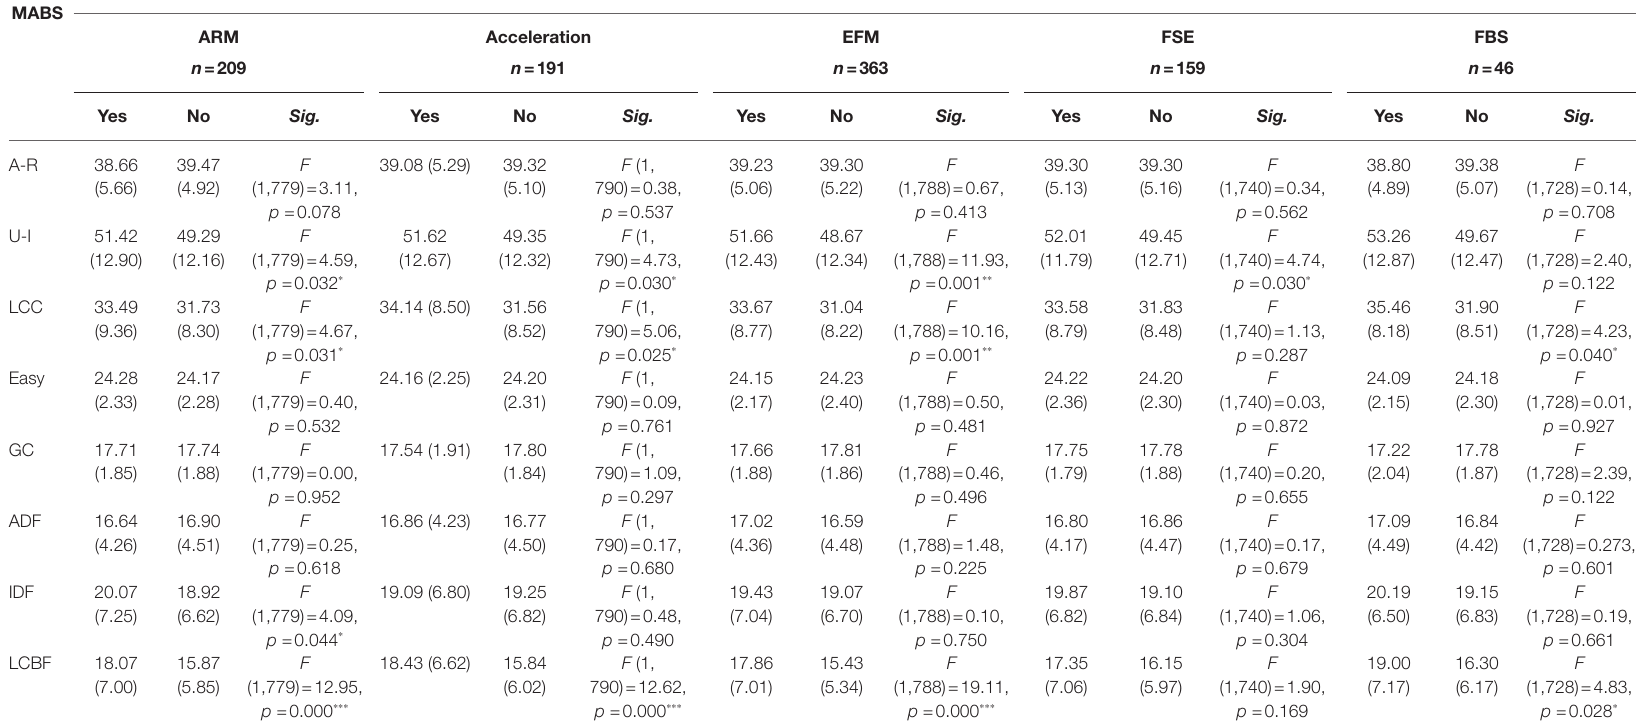
Labour intervention—M (SD) and significance